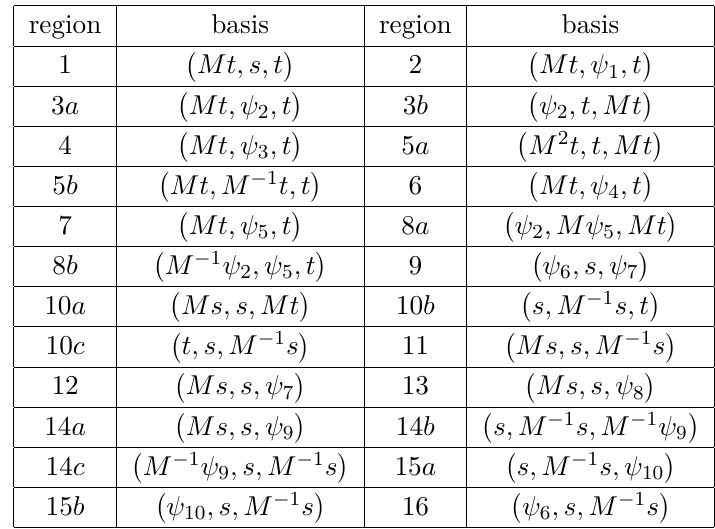
Table 1 . Bases of local WKB solutions for the 16 regions shown in figure